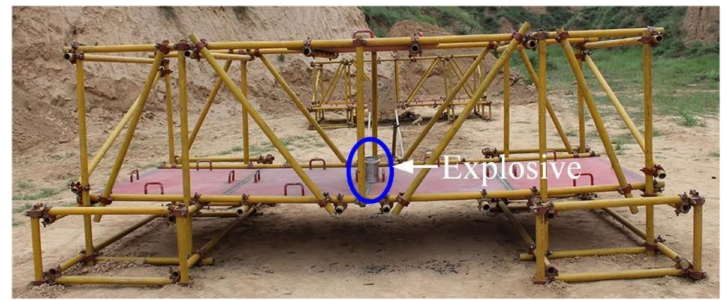
Figure 2. Position of the explosive for the scenario without explosion height.